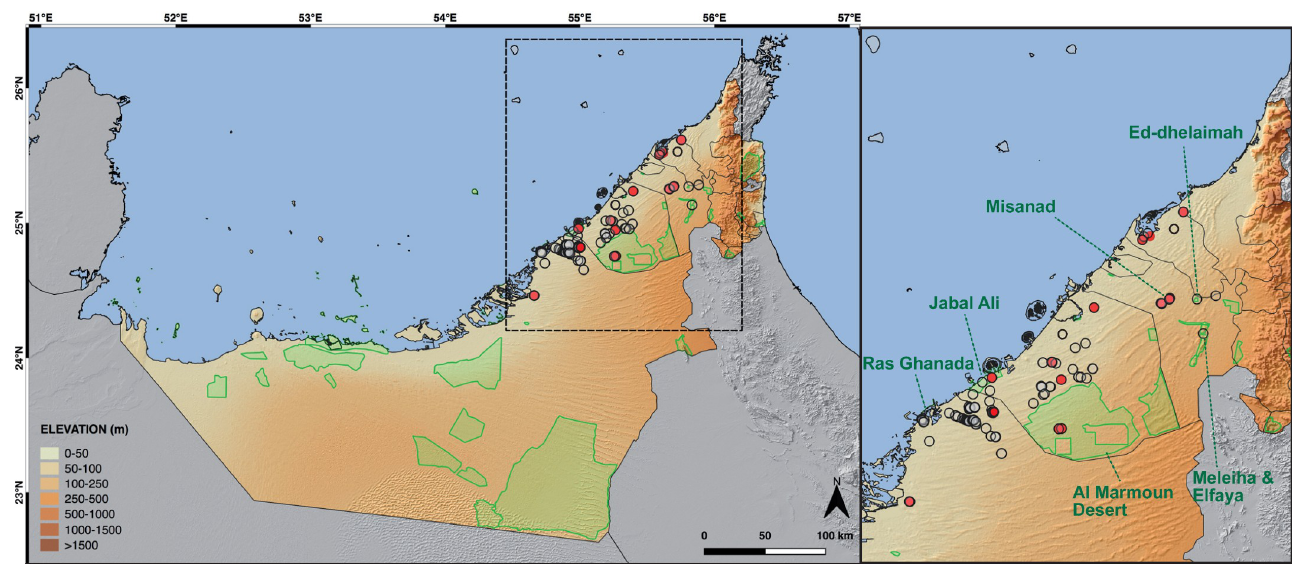
Fig 7. Distribution of T . keyserlingii in the UAE within the current terrestrial protected areas. Terrestrial protected areas are indicated in green (see details in Burriel-Carranza et al., 2019) [28]. Circles indicate T . keyserlingii specimens used in this study (red) and past known localities (blank). Credits: OpenStreetMap contributors, SRTM. Shapefile of the terrestrial protected areas of the UAE is provided in S1